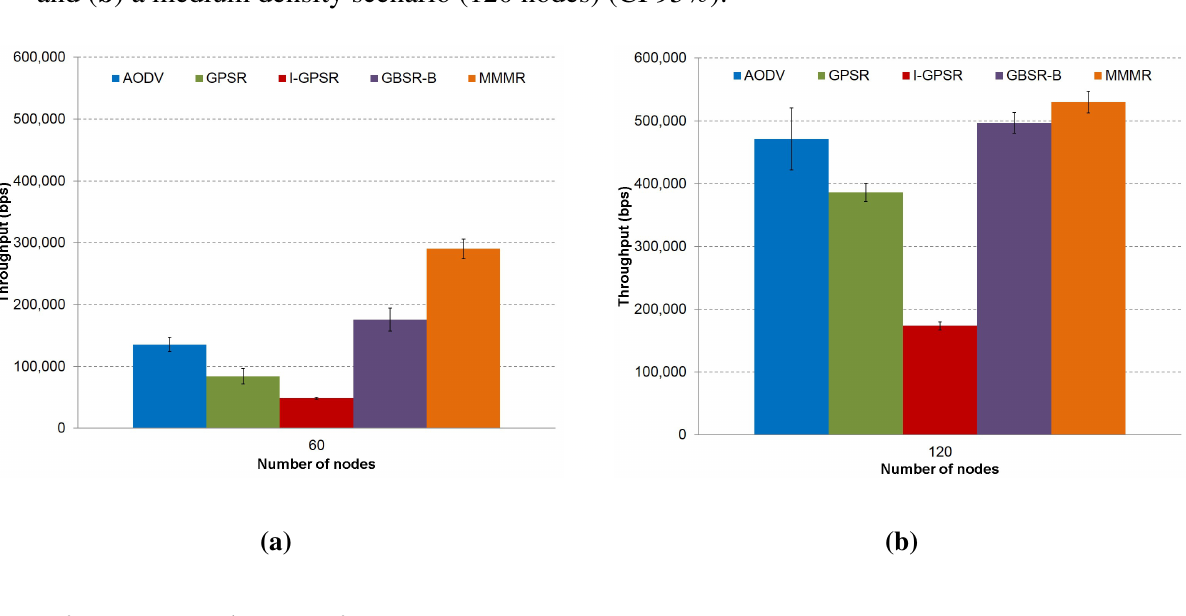
Figure 7. The total throughput of the received packets comparing the protocols, AODV, GPSR, I-GPSR, GBSR-B and MMMR, are presented in ( a ) a low density scenario (60 nodes) and ( b ) a medium density scenario (120 nodes) (CI